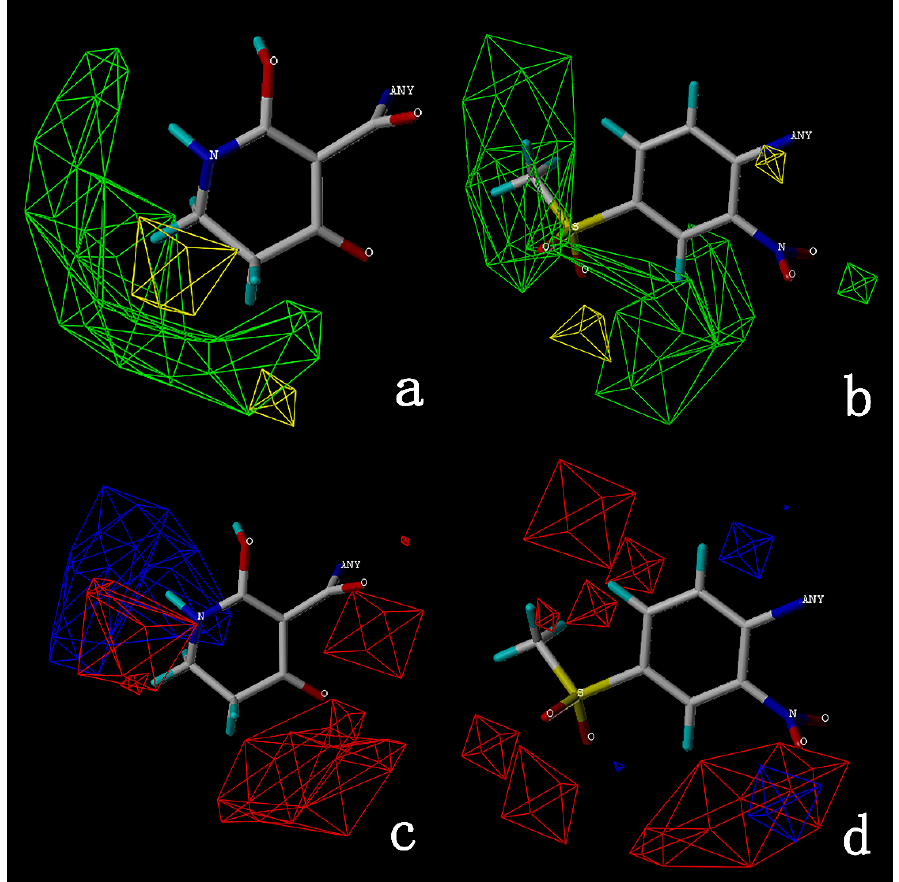
Figure 3. Topomer CoMFA steric ( a , b ) and electrostatic ( c , d ) contour maps based on the R 1 and R 2 groups of the most active ZD-9.